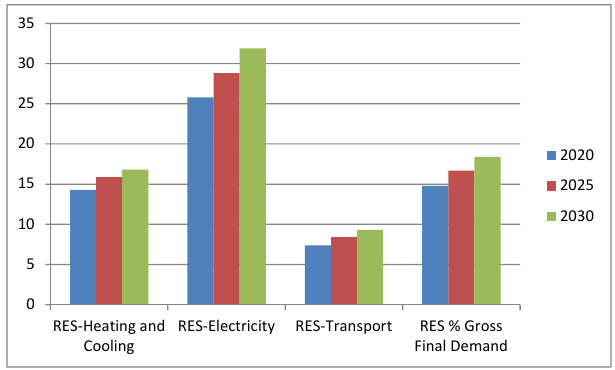
Figure 2. Green energy share prognosis at the EU level [11].